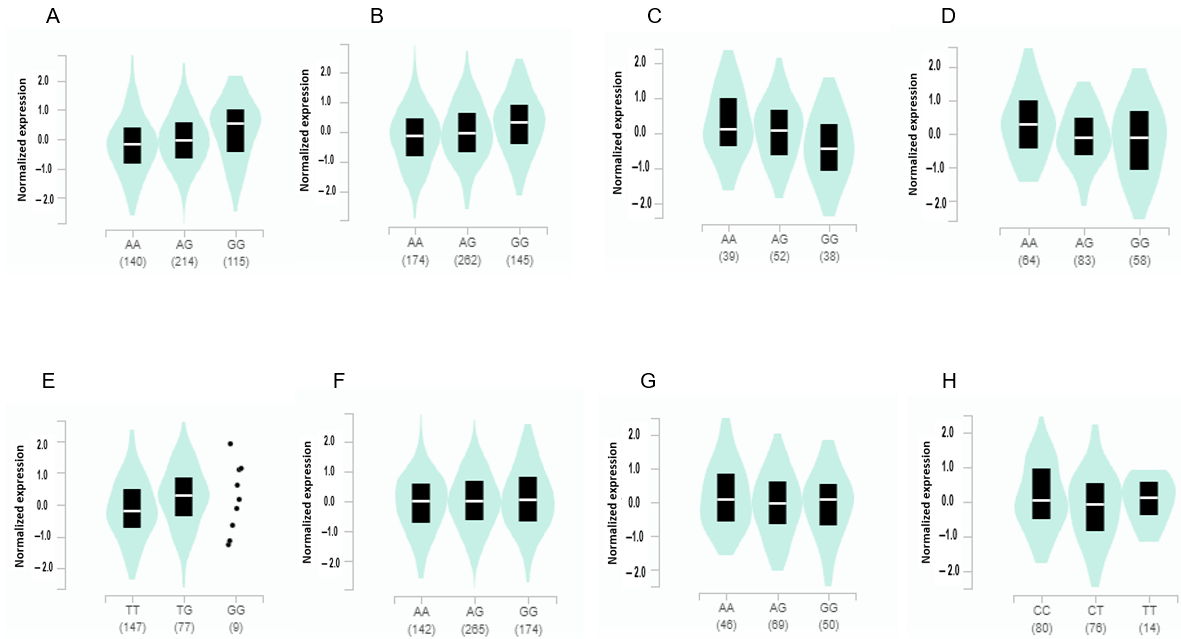
Figure 3. Gene expression according to the alleles of the selected SNPs for high body fat risk in different tissues. ( A ) ADCY3_ rs6545790 in visceral adipose tissues (slope of the SNP alleles = 0.21, p = 4.1 × 10 − 14 ). ( B ) ADCY3_ rs6545790 in subcutaneous adipose tissues (slope of the SNP alleles = 0.23, p = 2.2 × 10 − 19 ). ( C ) ADCY3_ rs6545790 in the amygdala (slope of the SNP alleles = − 0.18, p = 0.0064).